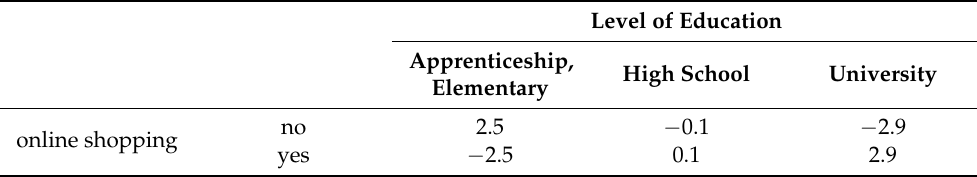
Table 4. Adjusted standardized residuals, threshold 2.638 (variables online organic food shopping and highest education).